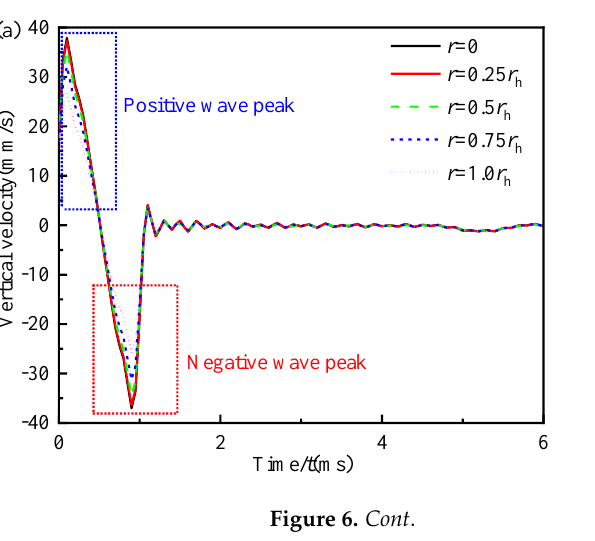
Figure 5. Velocity response in time domain of different test points along the radial direction within the excitation region for pile with R = 0.25 m: ( a ) r h = 0.01 m; ( b ) r h = 0.02 m; ( c ) r h = 0.04 m; ( d ) Variation of the negative-positive-ratio.